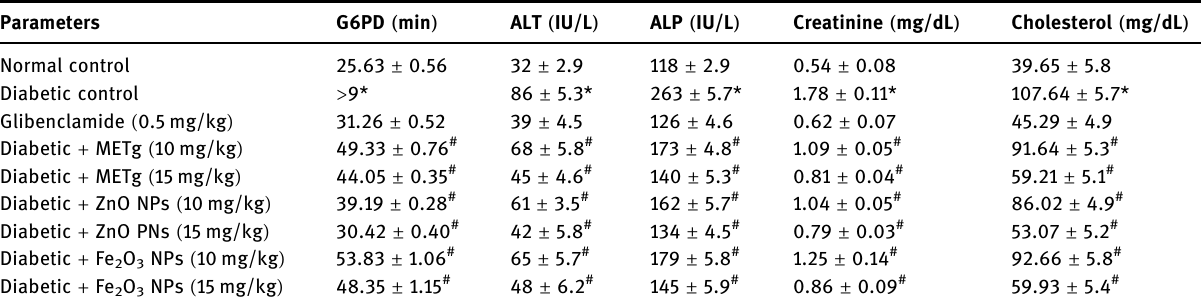
Table 3: E ff ect of T. glabra methanolic extract, and their mediated ZnO NPs and Fe 2 O 3 NPs on G6PD, ALT, ALP, creatinine, and cholesterol on diabetic